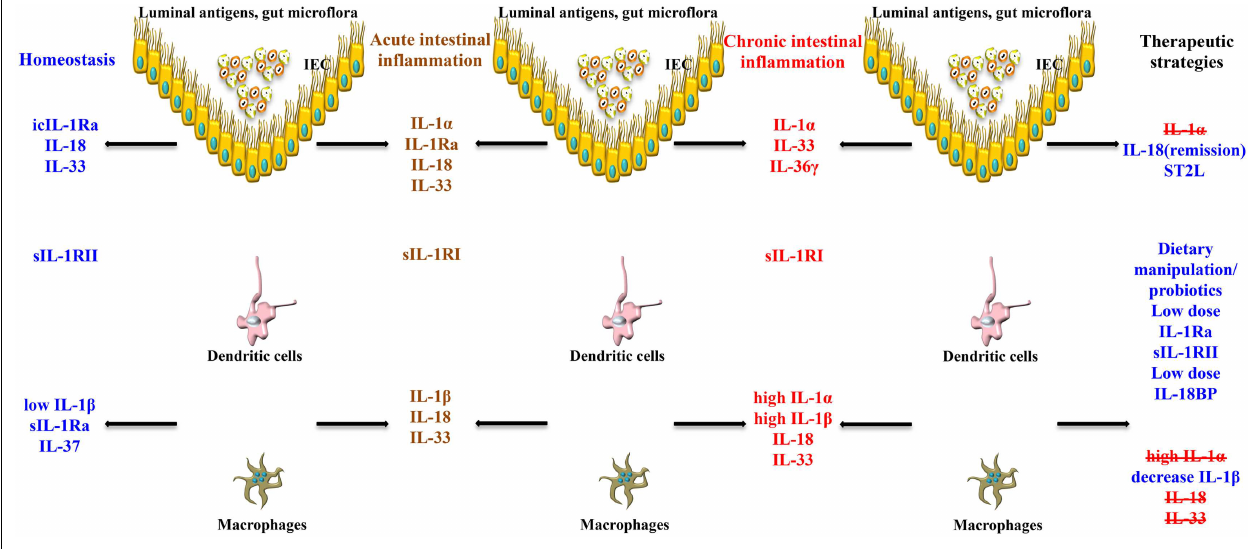
together with sIL-1Ra, IL-37, and low levels of IL-1 β produced by APCs, and sIL-1RII shed by macrophages, promote physiological inflammation, and homeostasis. Chronic intestinal inflammation results when this balance is disrupted, often changing the cellular sources and absolute levels of IL-1 family members. Based on this imbalance, therapeutic strategies aimed at modulating levels of IL-1 family members can be designed to reestablish gut